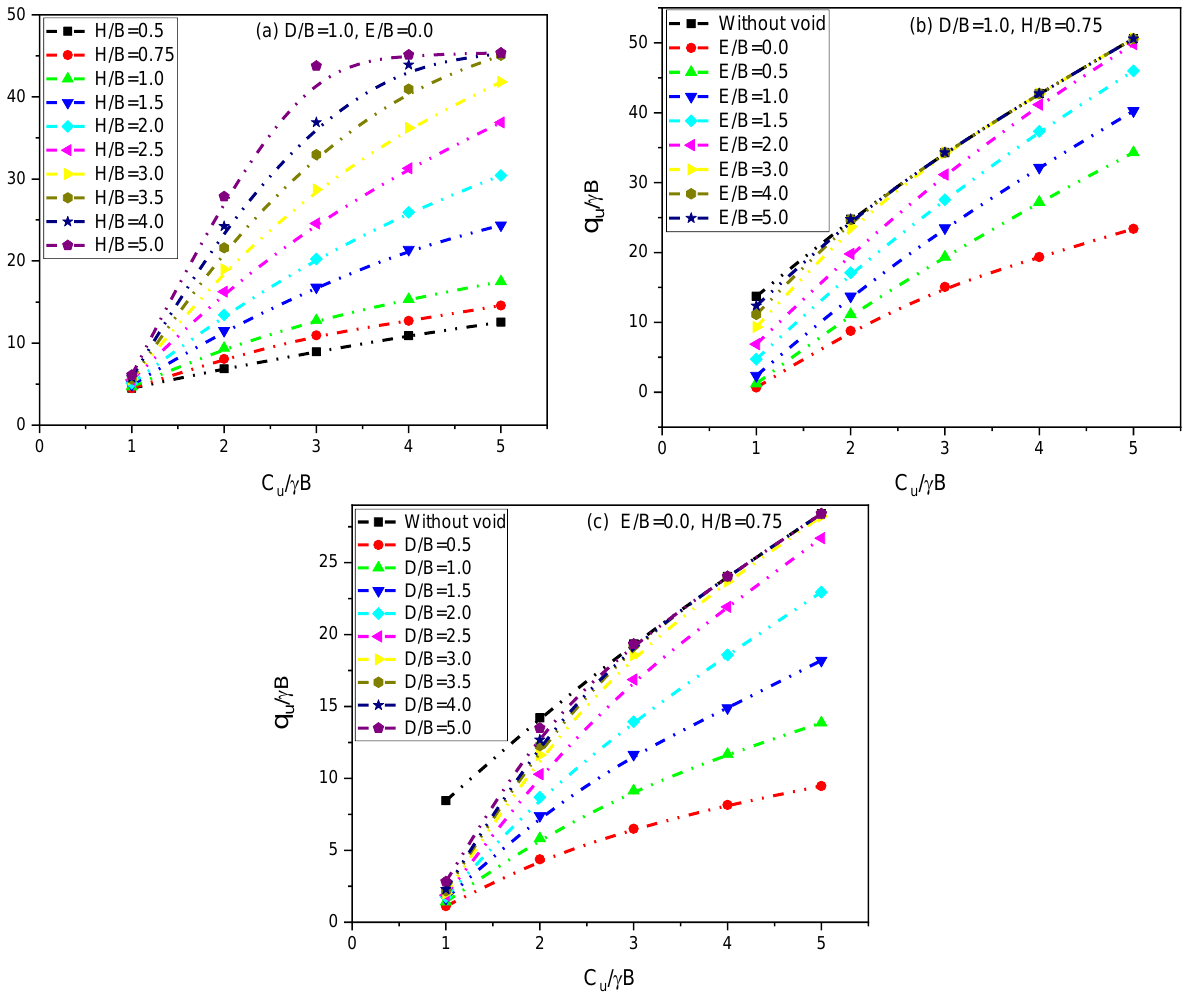
Figure 5. Effect of clay parameter Cu/γB on the ultimate bearing capacity ratio qu/γB.